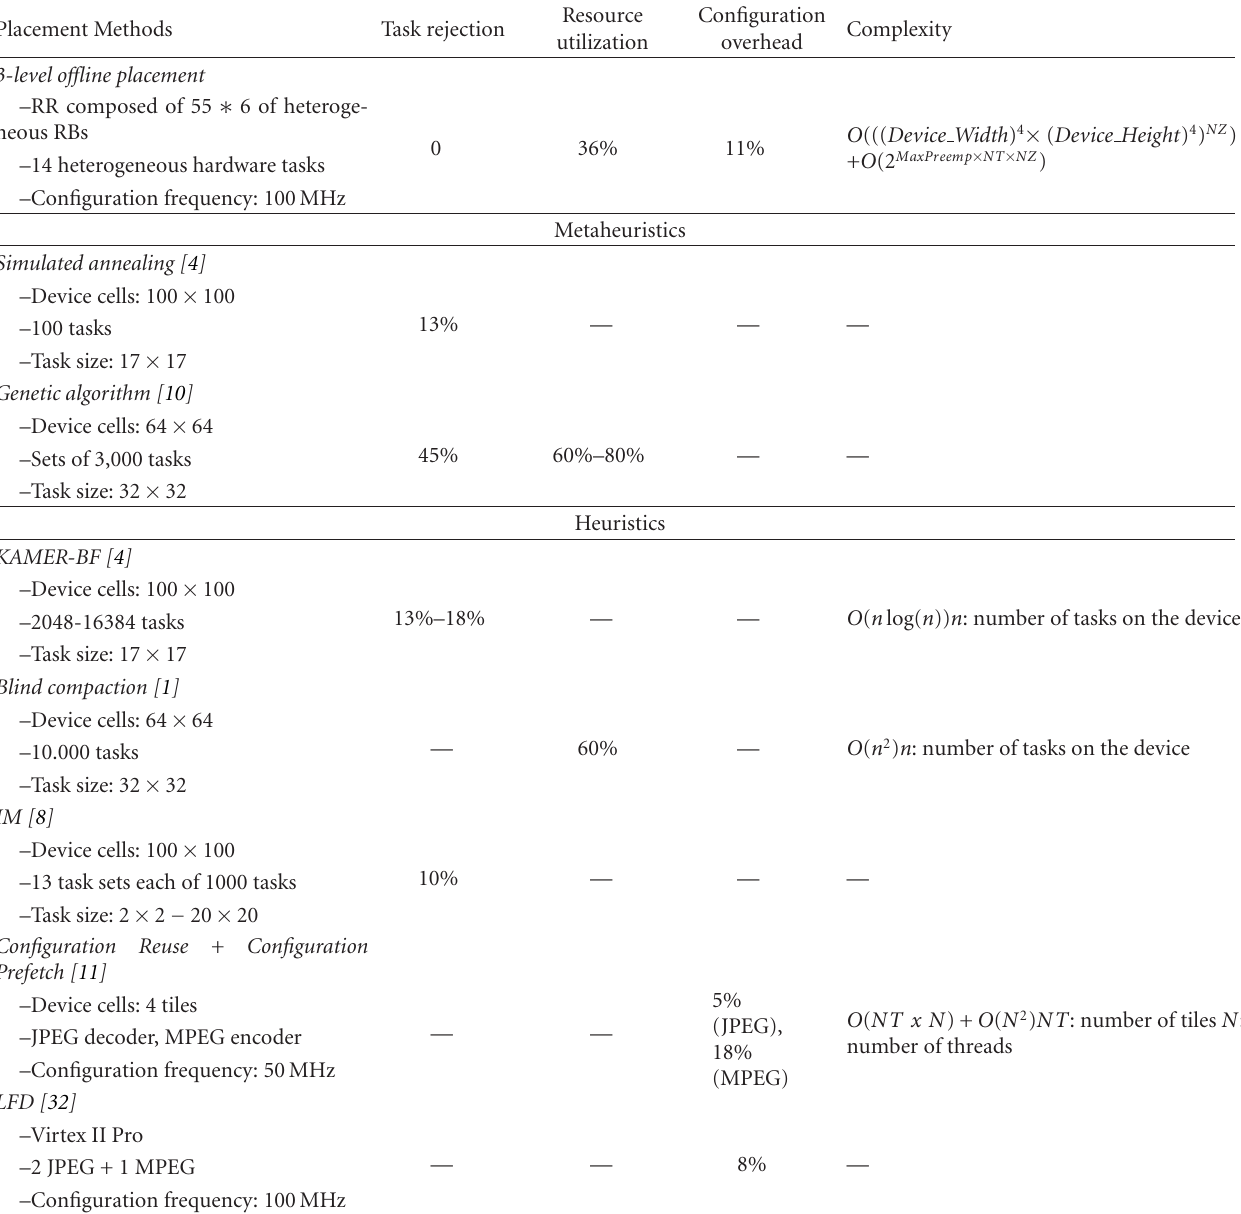
Table 6: Placement results